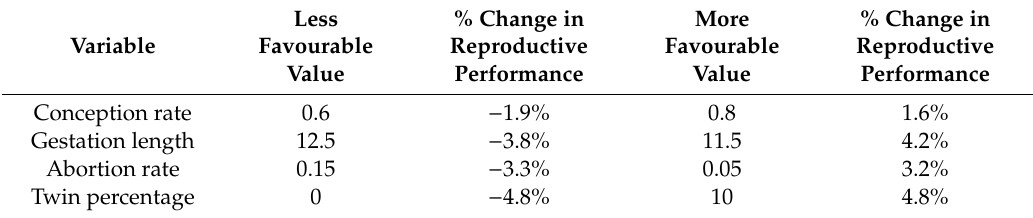
Table 2. Percentage change in reproductive performance compared to middle scenario using less and more favourable values for individual